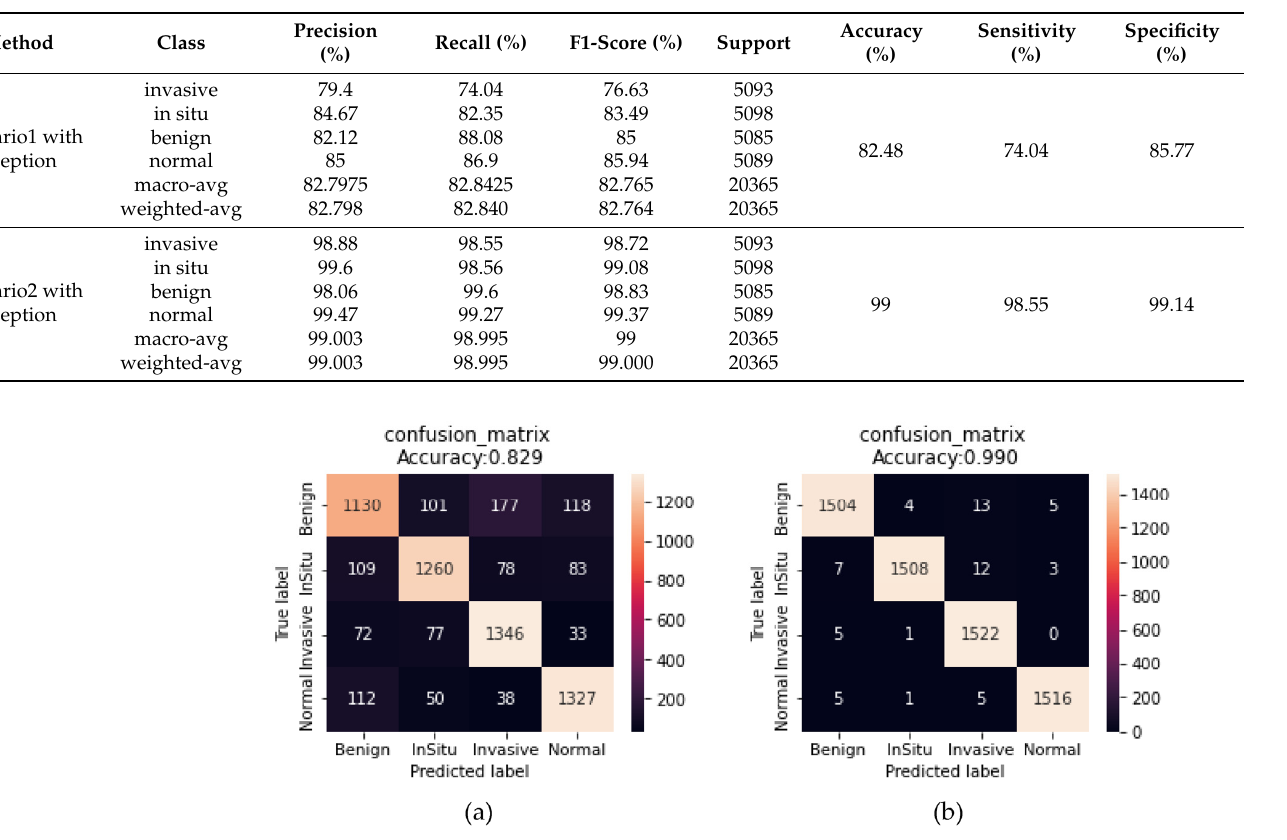
Figure 19. Confusion matrix of the scenarios: ( a ) Scenario1; ( b ) Scenario2 for breast cancer classifica- tion with data augmentation.